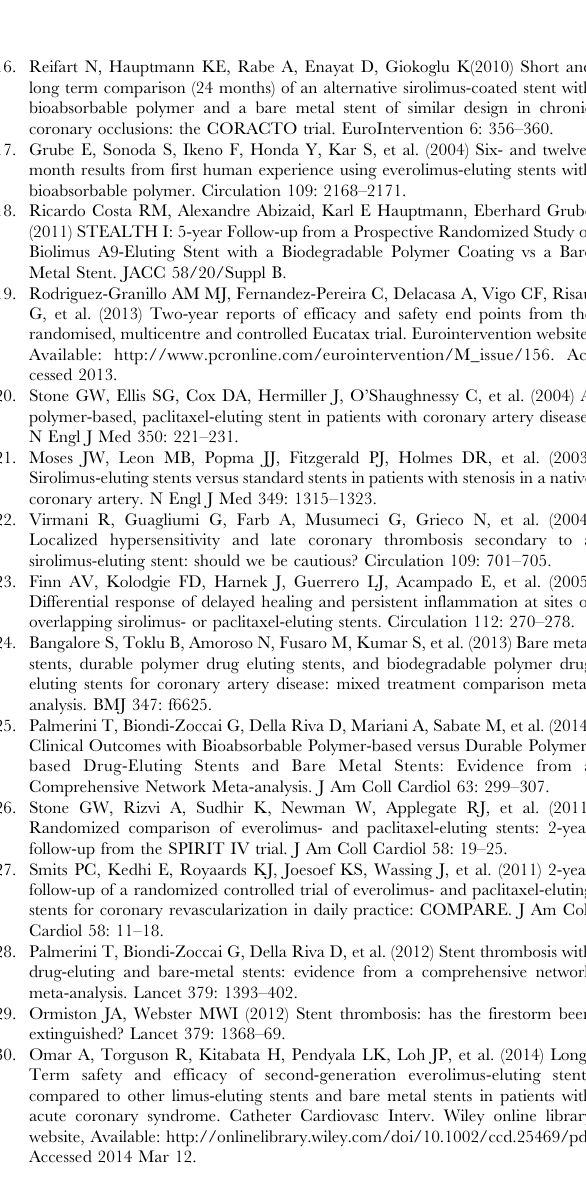
Figure S15 Individual and summary odds ratios for early definite stent thrombosis in patients treated with BP-limus eluting stents vs. BMS. Figure S16 Individual and summary odds ratios for late definite stent thrombosis in patients treated with BP-limus eluting stents vs. BMS. Figure S17 Standardized mean difference (SMD) for ISLL in patients treated with BP-limus eluting stents vs. BMS. Figure S18 Individual and summary odds ratios for death in patients treated with BP-SES vs. BMS. Figure S19 Individual and summary odds ratios for myocardial infarction in patients treated with BP-SES vs. BMS.